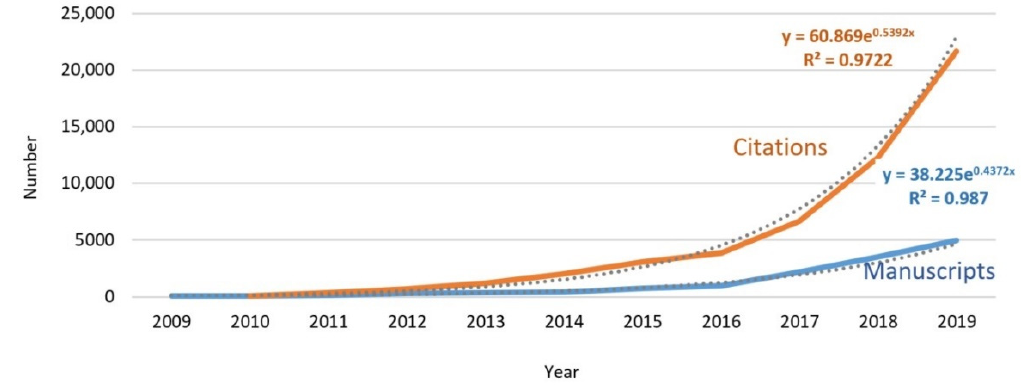
Figure 6. Distribution of published documents and citations by year. Figure 6 . Distribution of published documents and citations by year. Figure 6 . Distribution of published documents and citations by year.